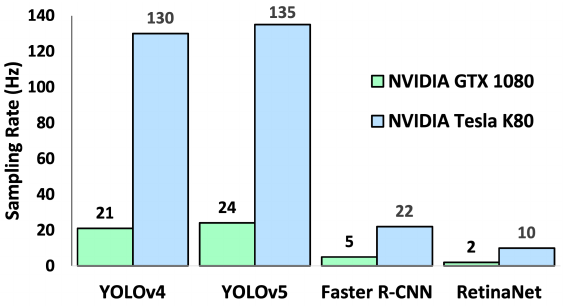
Figure 8. Sampling/inference rates in Hz are shown for two YOLO architectures, Faster R-CNN, and RetinaNet object detection